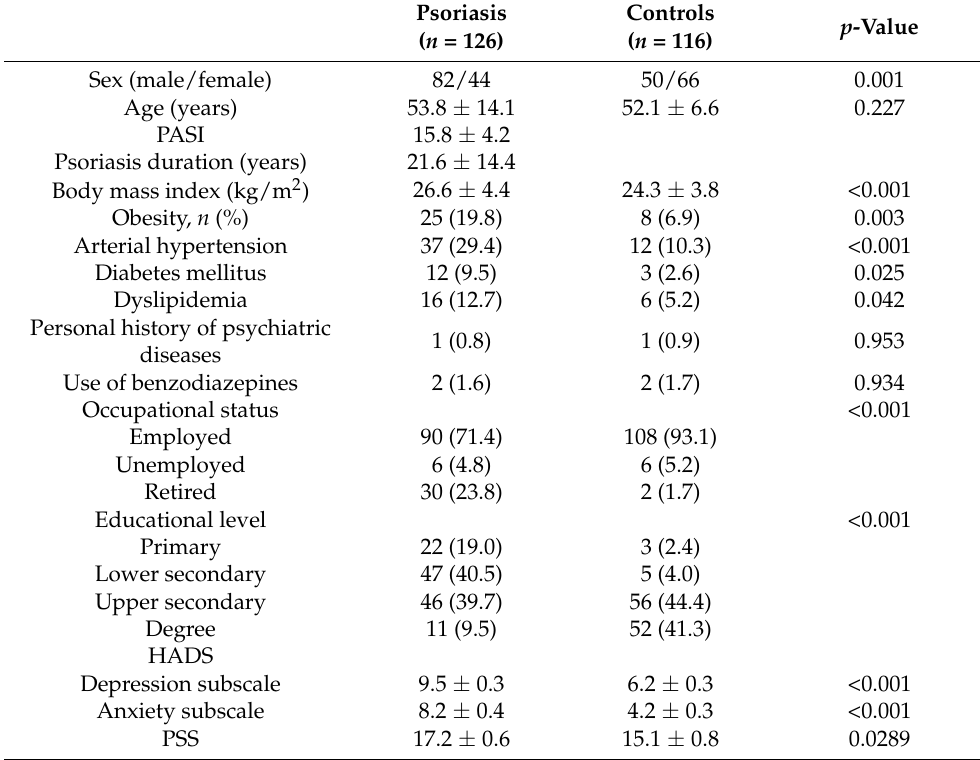
Table 1. Clinical and sociodemographic characteristics of patients with psoriasis and controls.